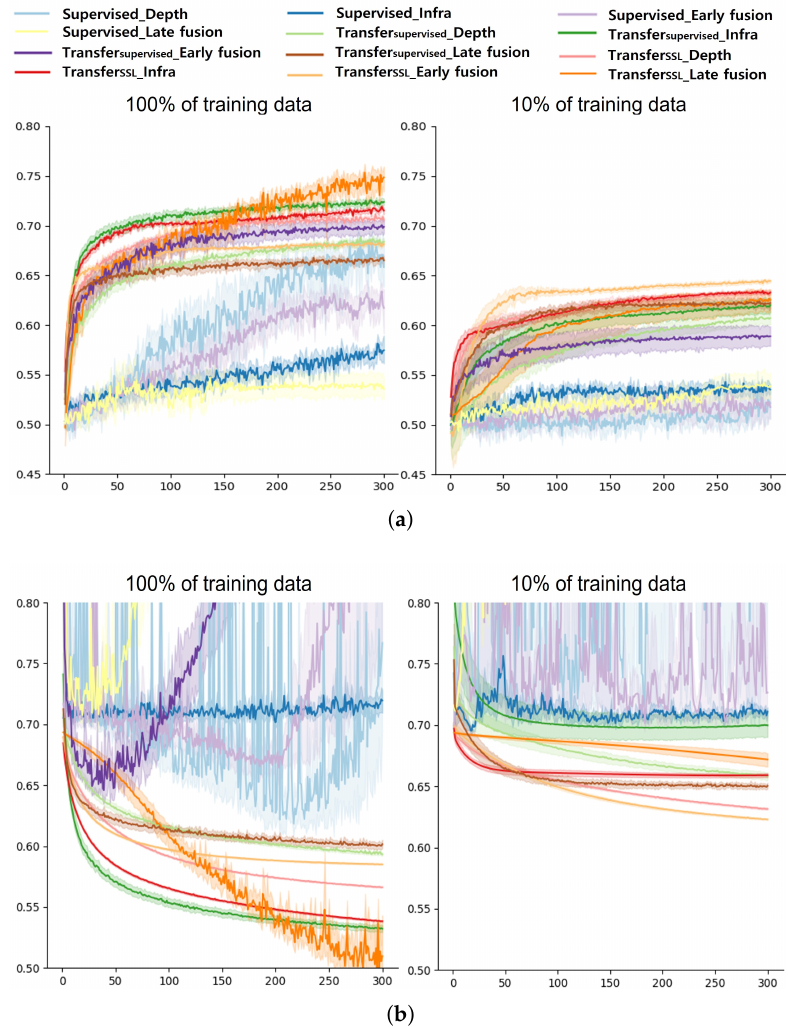
Figure 8. Accuracy and loss of each method per epoch. ( a ) Comparison of validation accuracy, ( b ) Comparison of validation